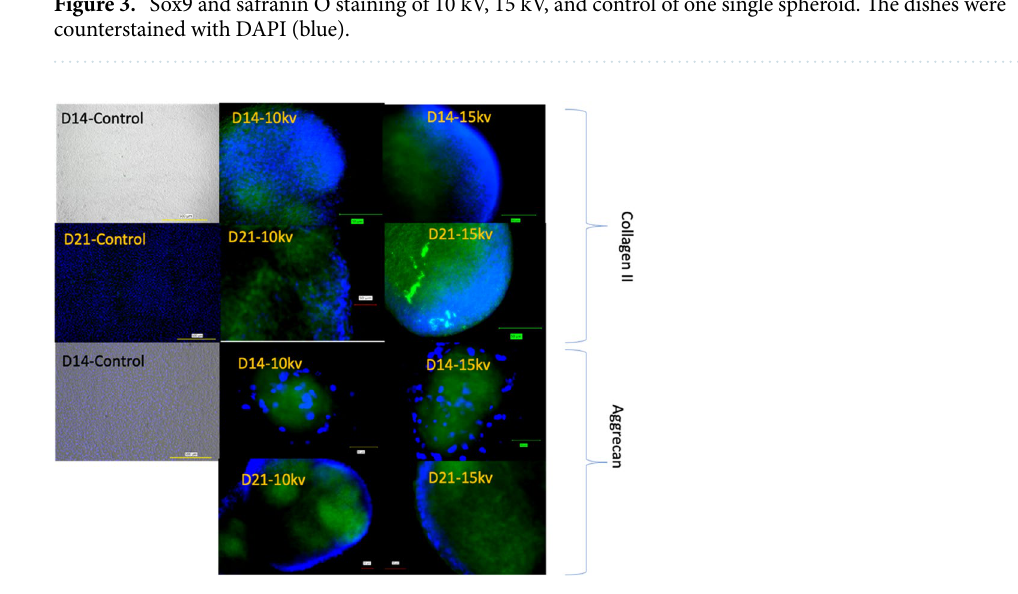
Figure 4. Collagen II and aggrecan (green) staining of 10 kV, 15 kV, and control of one single spheroid. The dishes were counterstained with DAPI